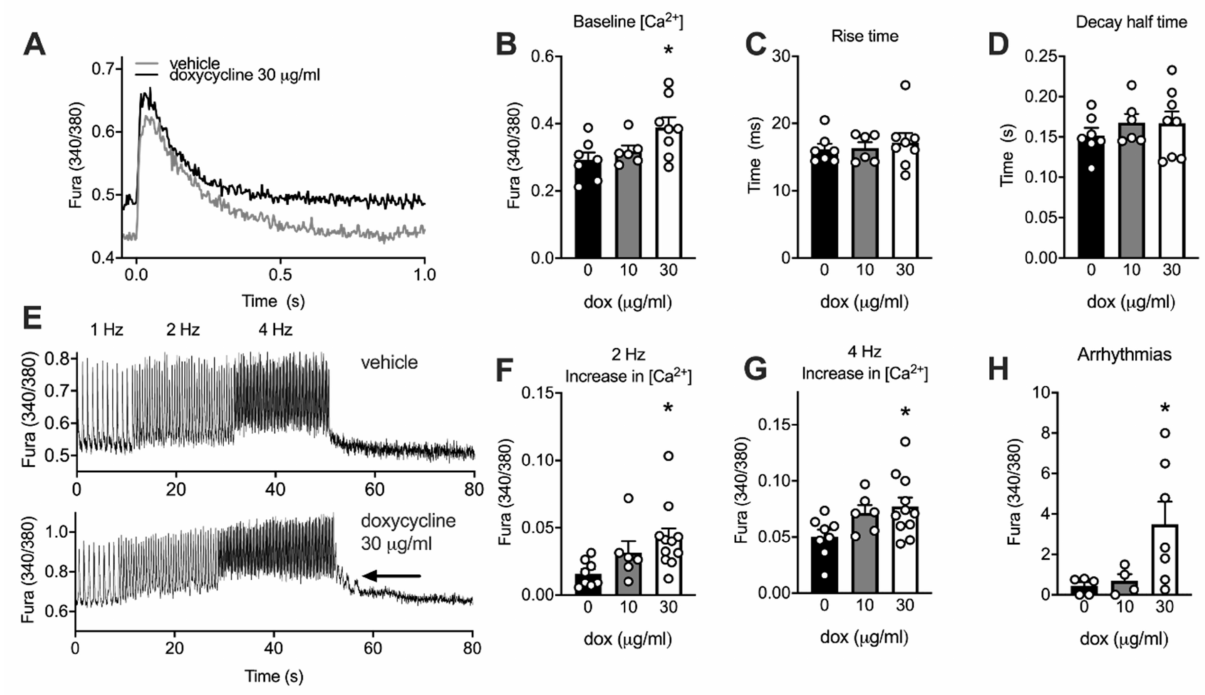
Figure 4. Higher resting cytosolic calcium and more arrhythmias in adult cardiomyocytes exposed to doxycycline. ( A ) Typical examples of calcium transients (340/380 ratio) obtained from adult rat cardiomyocytes exposed maximal 48 h to doxycycline, electrically stimulated at 1 Hz. ( B ) Baseline cytosolic Ca 2+ concentration was significantly higher after exposure to 30 µ g/mL doxycycline compared to vehicle. ( C – D ) No differences were observed in the shape of the calcium transient. ( E ) Typical examples of calcium transients of vehicle-treated (top) and doxycycline-treated (30 µ g/mL; bottom) adult rat cardiomyocytes electrically stimulated at 2 and 4 Hz for 20 s (after a period at 1 Hz). Arrow point to irregular Ca 2+ waves, quantified in H. ( F – G ) At higher stimulation frequencies (2 and 4 Hz), baseline (diastolic) calcium increased to a larger extent in doxycycline-treated cells. ( H ) More arrhythmias were observed in adult cardiomyocytes treated with 30 µ g/mL doxycycline during and straight after about 2 and 4 Hz. Bar graphs are expressed as mean ± SEM. *: P < 0.05 vs. vehicle, one-way ANOVA followed by Tukey’s post-hoc test for multiple